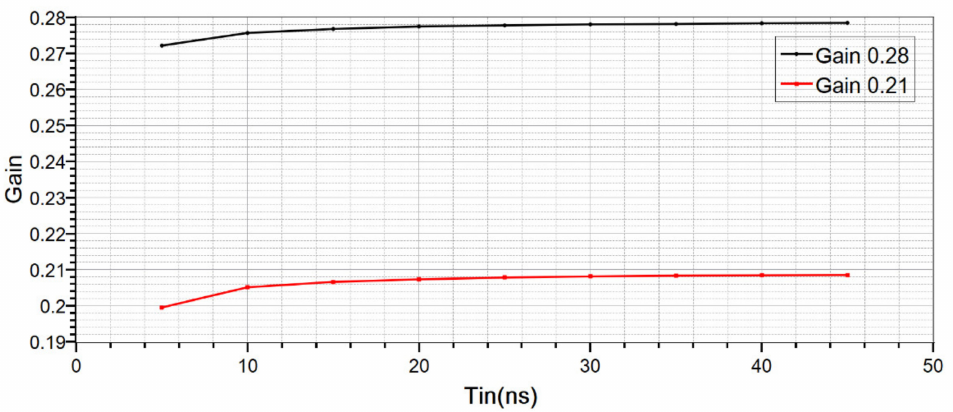
Figure 11. Two cases of multiplication coefficients with nominal values of 0.28 and 0.21 in relation to input pulse width T in